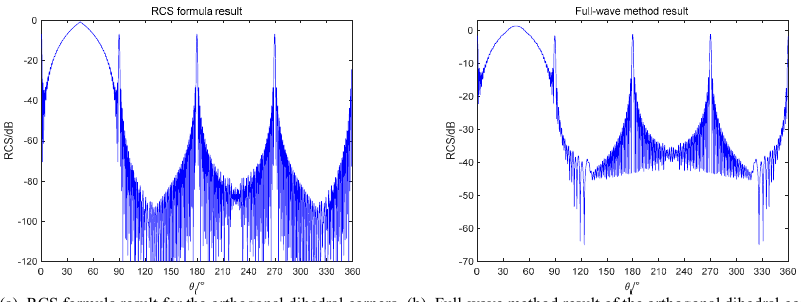
Figure 12. Monostatic RCS of the orthogonal dihedral ( a ) RCS formula in this paper; ( b ) Full-wave method.